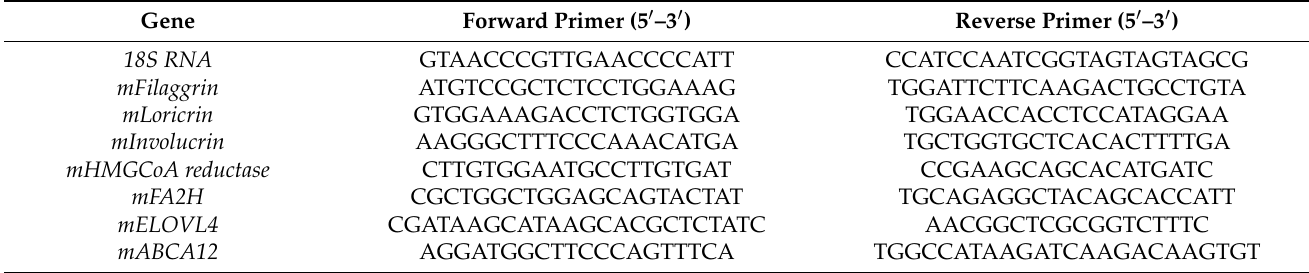
Table A2. Primers for